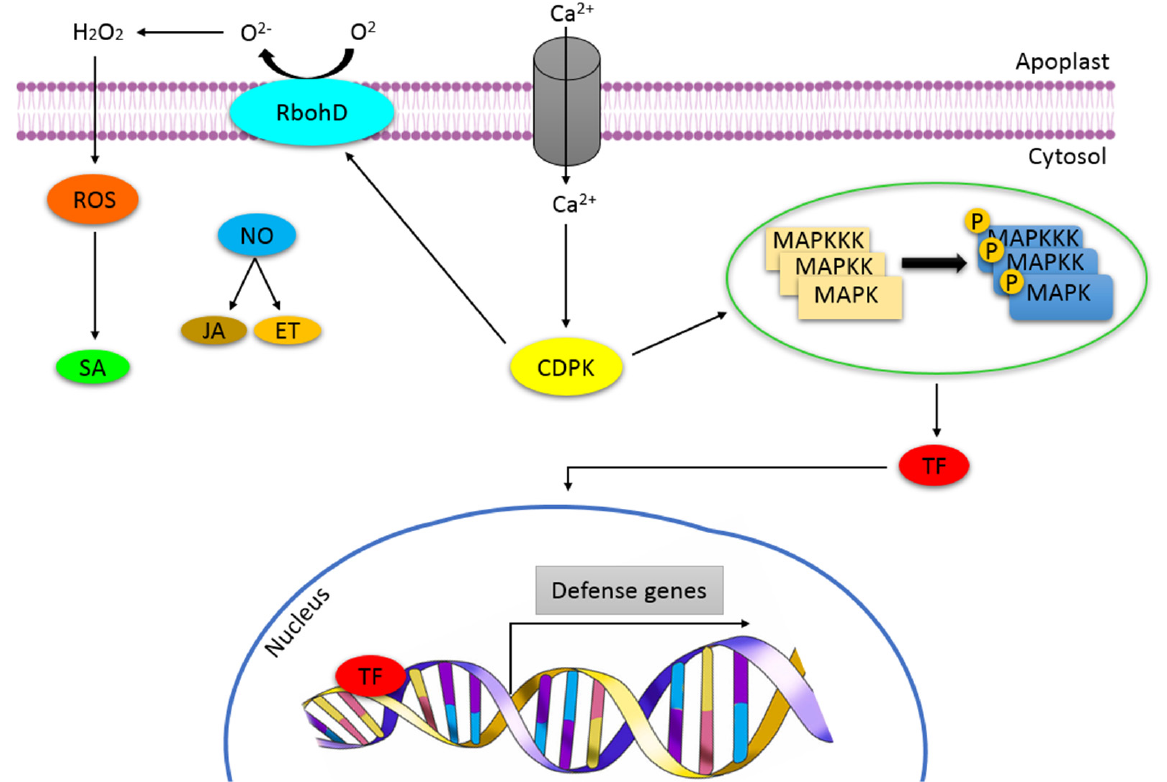
Figure 1. Overview of defence signalling in plants under abiotic stress. Upon perception of stress, several secondary messengers such as ROS and Ca 2+ and NO are activated, which then induce different kinases such as CDPKs and MAPKs, resulting in the activation of transcription factors, enzymes and proteins which, in turn, activate the transcription of defence-related genes. Phytohormones, salicylic acid (SA), jasmonic acid (JA) and ethylene (ET), are also induced and contribute to plant